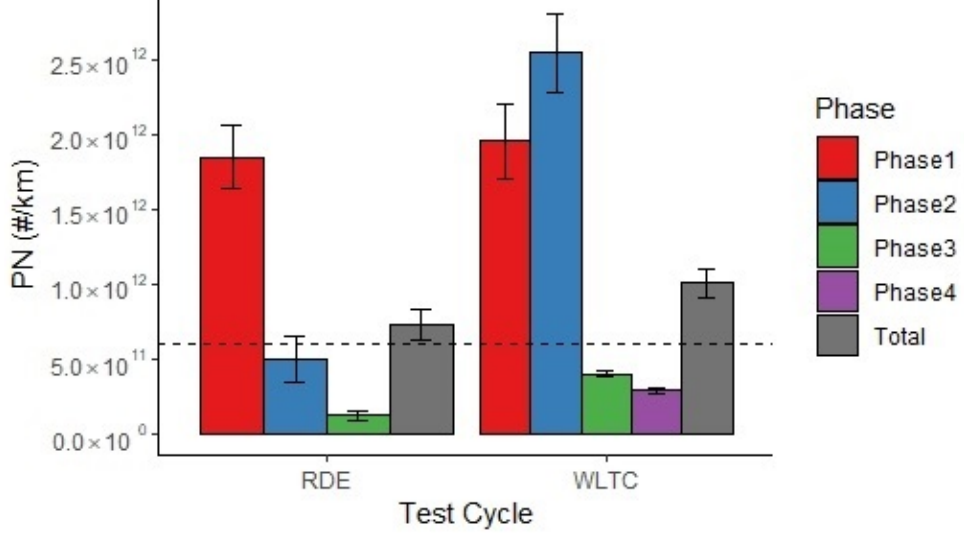
Figure 6. Average PN emissions per kilometre across the WLTC and RDE test cycles. Individual phase and total cycle results are given, along with the Euro 6 PN limit of 6 × 10 11 #/km (dotted line). Error bars represent the standard error of the repeats (two tests for WLTC, three tests for RDE).